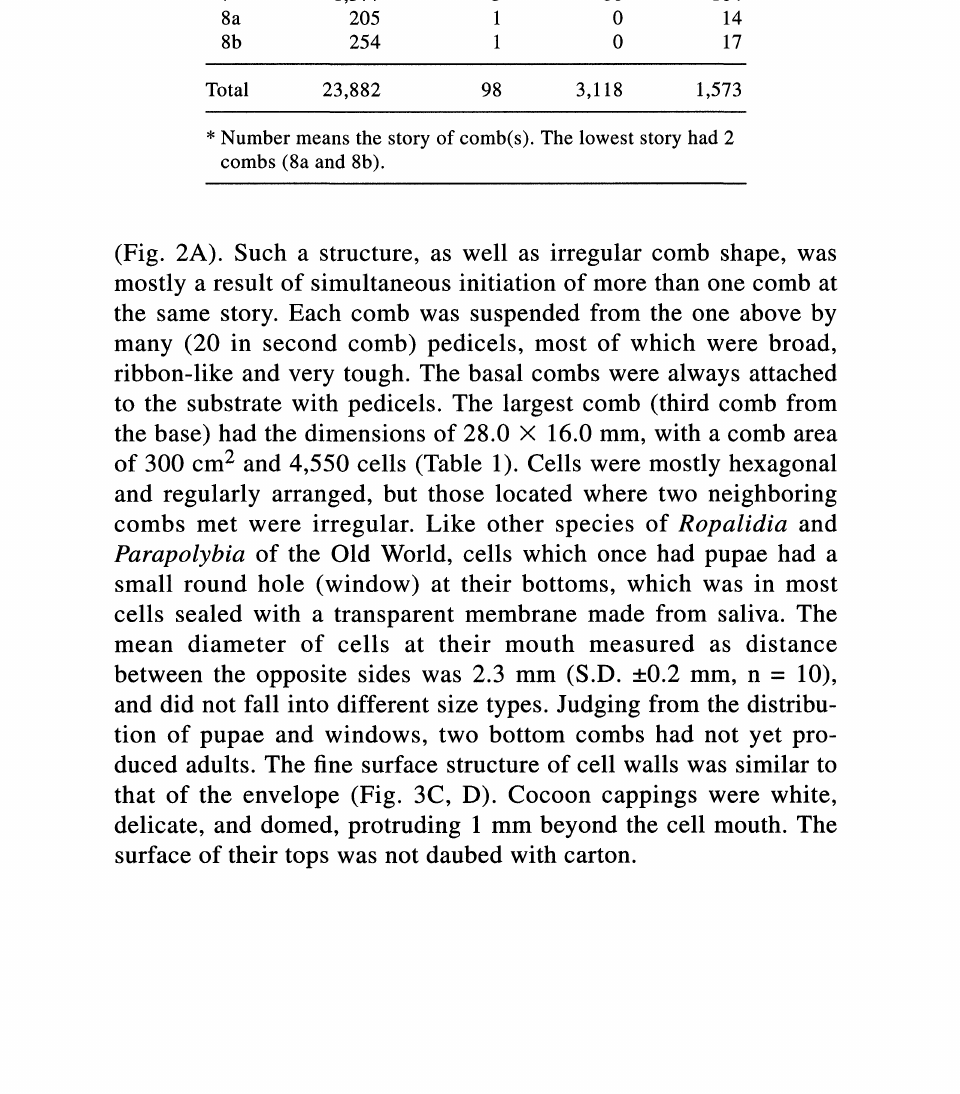
Table 1. Comb and cell composition of nest RM841 col- lected on 4 October 1984 at Griffith Univ., Nathan. Combs* No. No. No. Area cells petioles cocoons (cm 2) 2,967 21 61 195 2 3,750 20 599 247 3 4,740 17 659 312